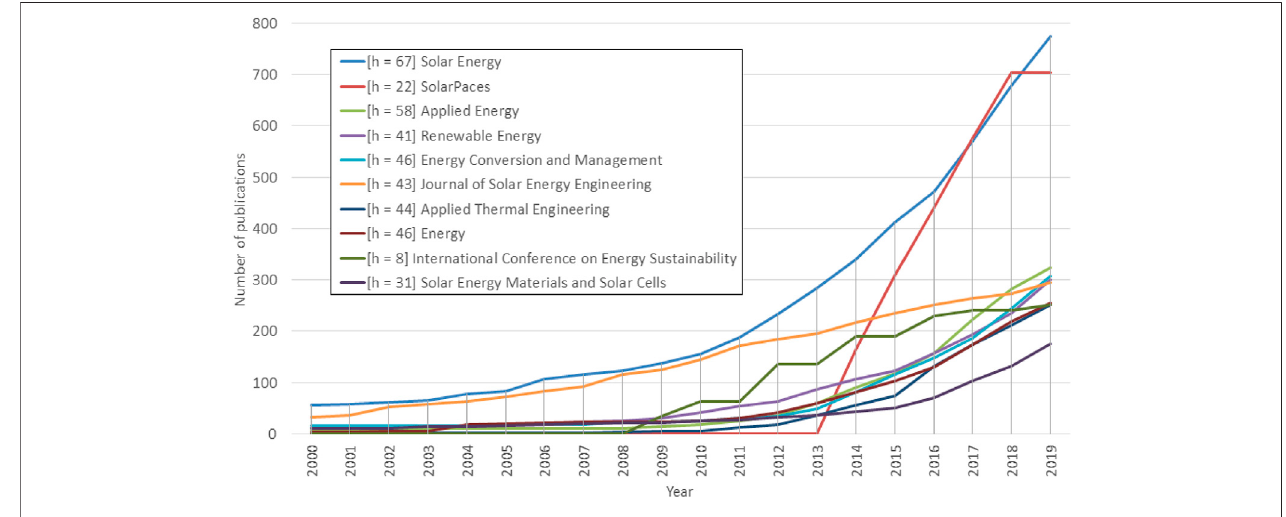
FIGURE 8 | Cumulative journal evolution, by number of